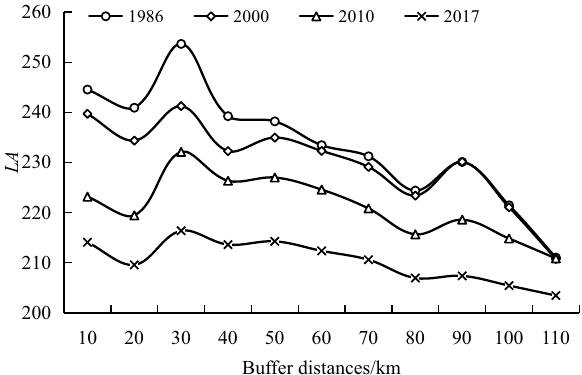
Figure 6. Comprehensive landscape degree index in the buffer zone of the